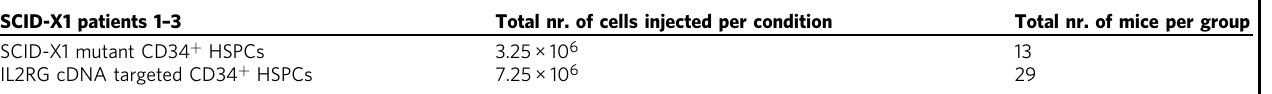
Table 3 Summary of SCID-X1 patients ’ derived CD34 + HSPCs transplants SCID-X1 patients 1 –